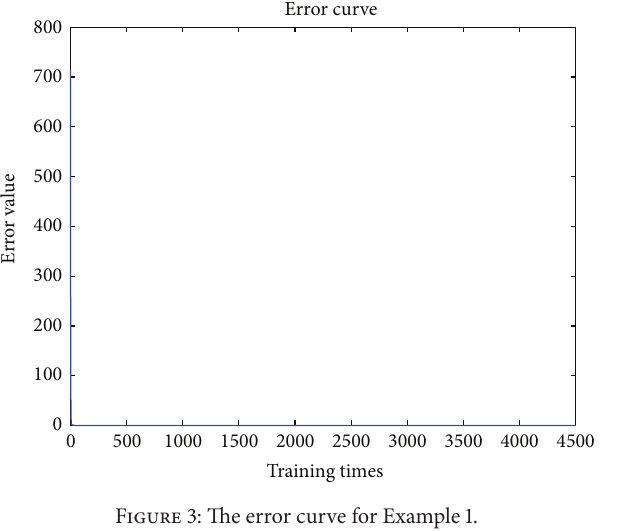
Figure 3: The error curve for Example 1.